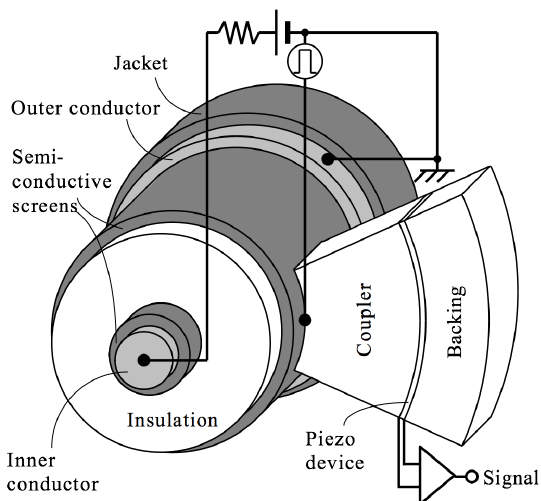
Figure 3. Cross-section schematic of the space charge measurement for a cable based on the pulsed electroacoustic method.